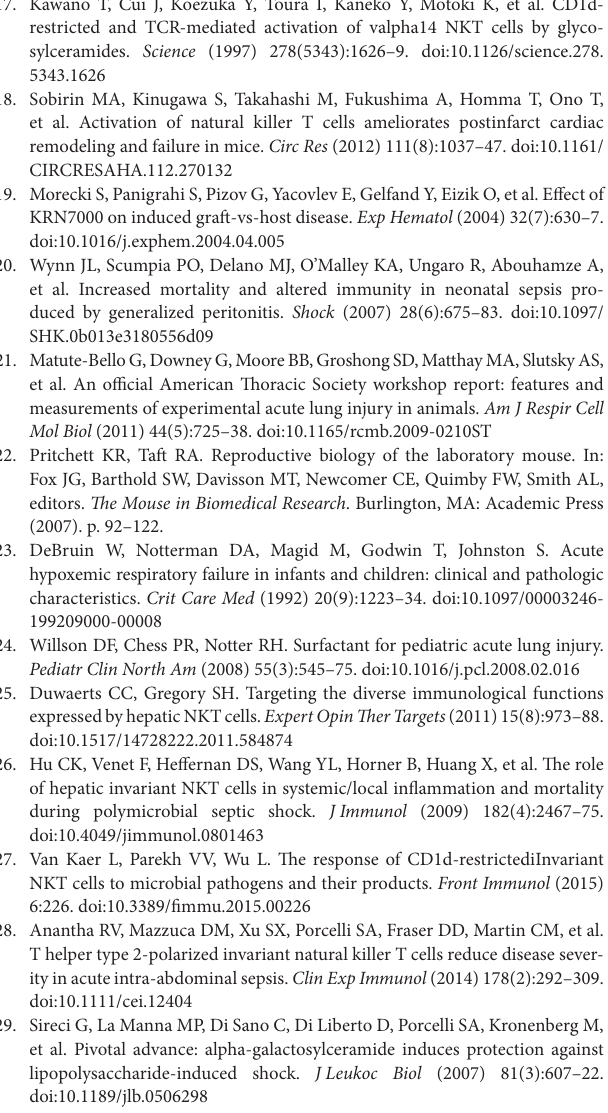
FigUre s1 | Kinetic analysis of KRN treatment on serum levels of various cytokines in neonatal mice. C57BL/6 pups received KRN (0.2 µg/g BW) i.p. Serum was harvested at 1, 5, 10, 20, and 30 h after KRN administration. Serum samples were pooled (5–10 samples per group) and a multi-analyte ELISArray was performed. Fold change in absorbance at 450 nm compared to baseline control (Ctrl) is shown. FigUre s2 | Effect of KRN treatment on serum levels of various cytokines in C57BL/6 WT and CD1d knockout (KO) neonatal mice. C57BL/6 WT and CD1d KO pups received KRN (0.2 µg/g BW) i.p. and serum was harvested 30 h later. Serum samples were pooled (5–10 samples per group) and a multi-analyte ELISArray was performed. Fold change in absorbance at 450 nm compared to baseline control is